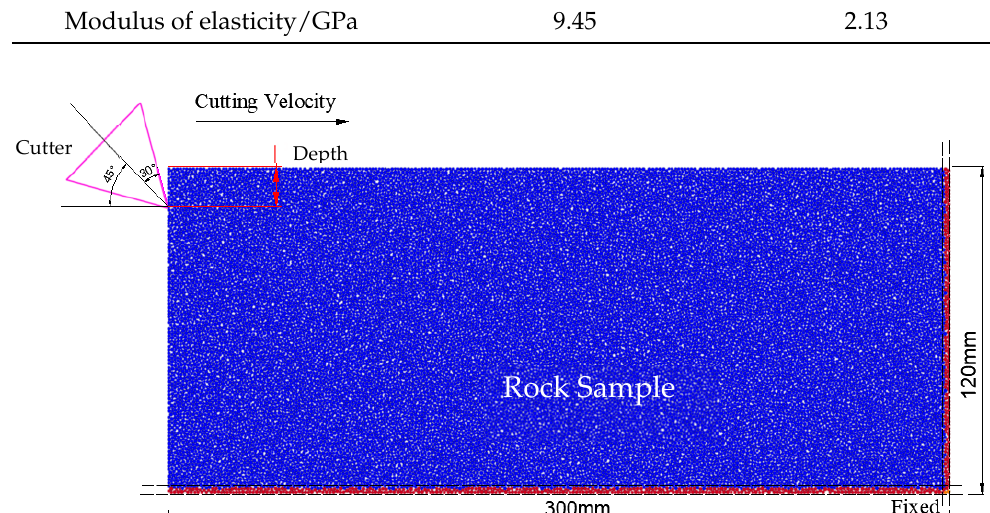
Figure 7. Schematic of the rock cutting model.